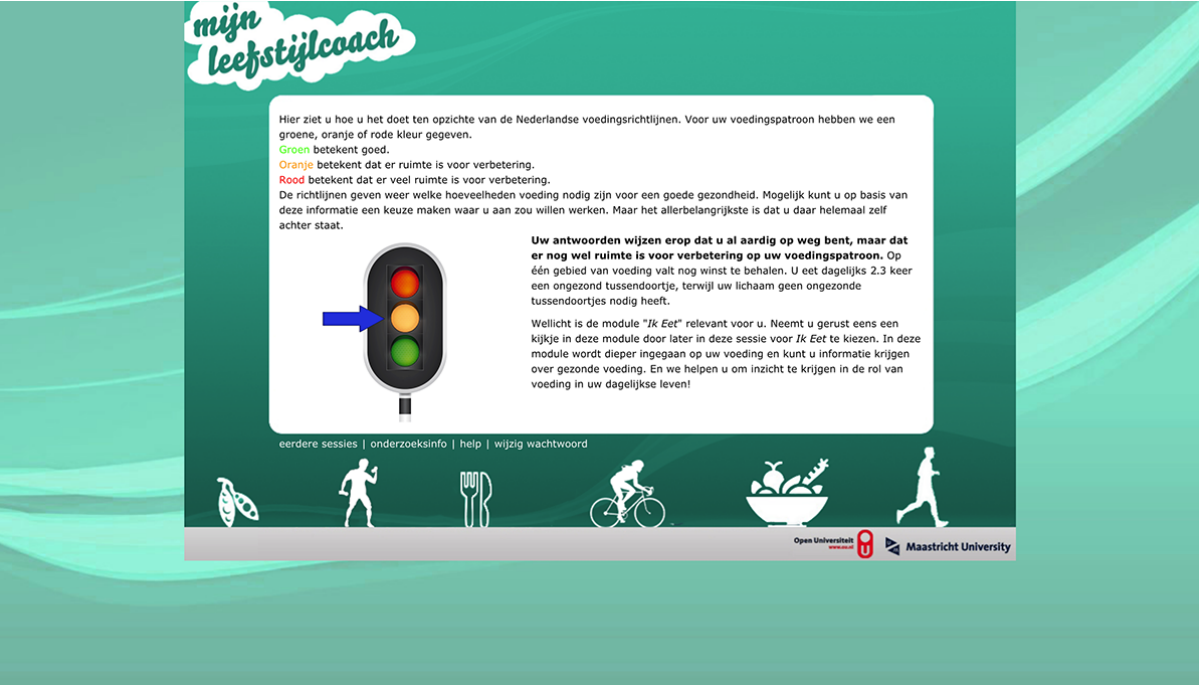
Figure 2. Screenshot of the page where people get advice in the opening